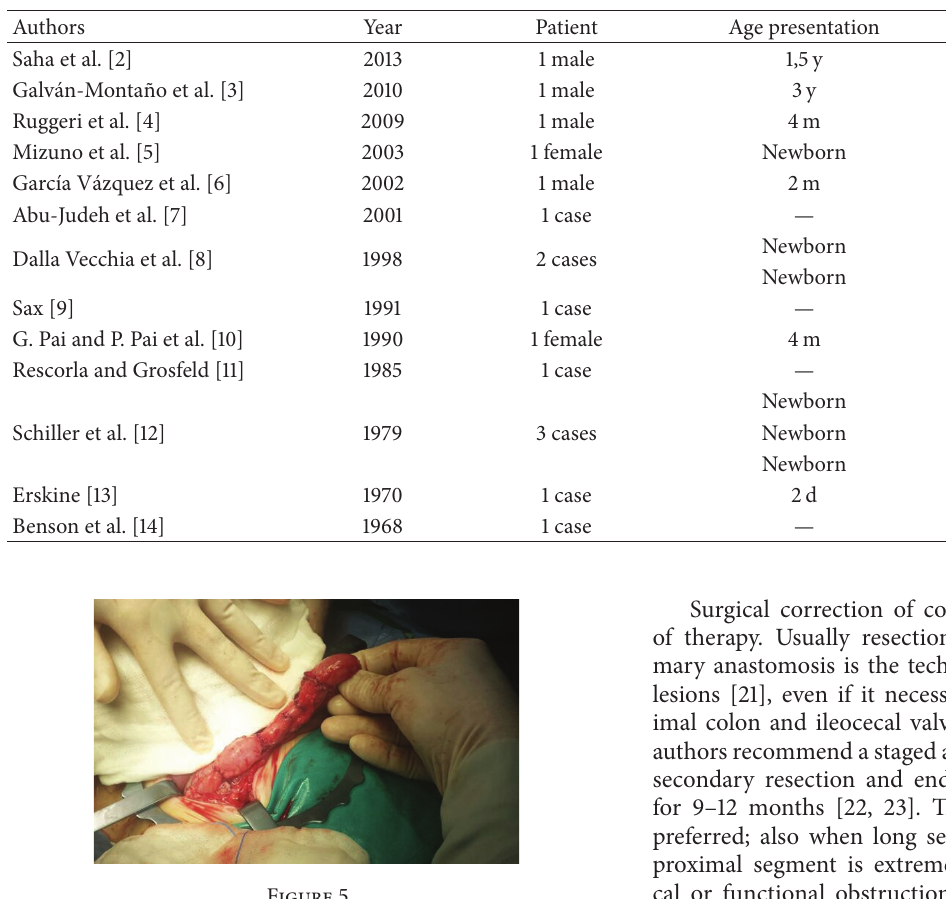
Table 1: Congenital colonic stenosis: cases reported from 1968 to